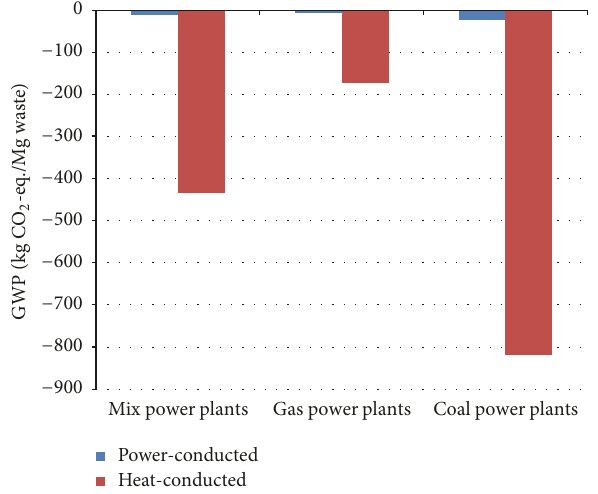
Figure 9: Heat credits for greenhouse effect GWP of power- conducted and heat-conducted WtE plants compared regarding different types of power